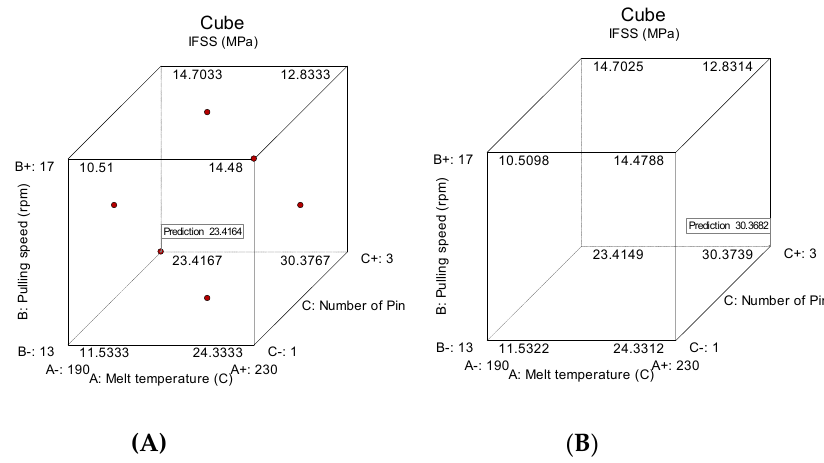
Figure 16. Optimisation solution at ( A ) the minimum melt temperature and ( B ) the maximum melt temperature.